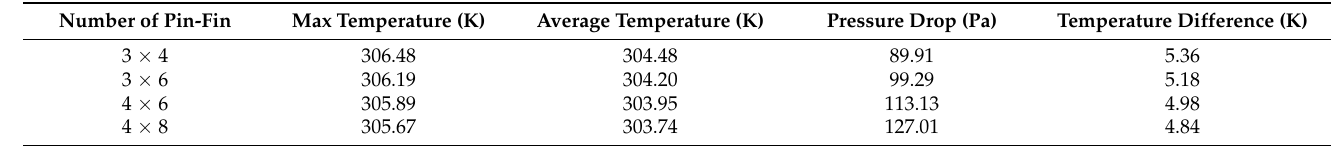
Table 6. Effect of various pin-fin